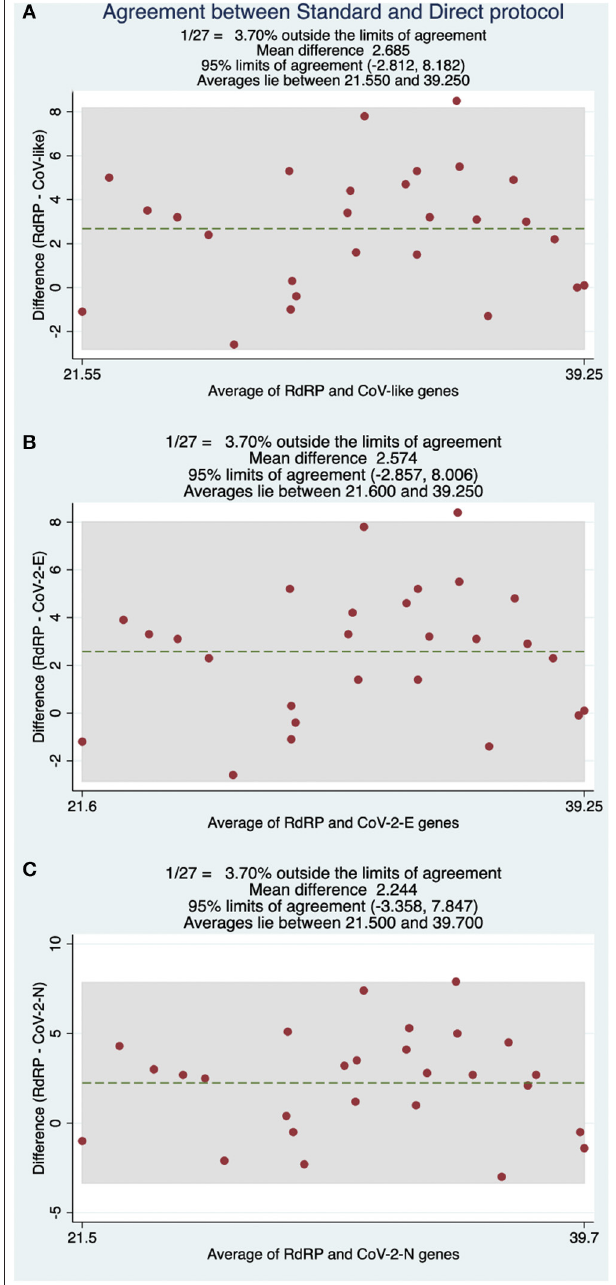
FIGURE 2 | Bland-Altman comparisons of Cq values obtained between the RdRP gene under standard protocol and (A) CoV-like, (B) CoV-2 E-gene, and (C) CoV-2 N-gene using a DNA-Technology kit with the direct protocol.